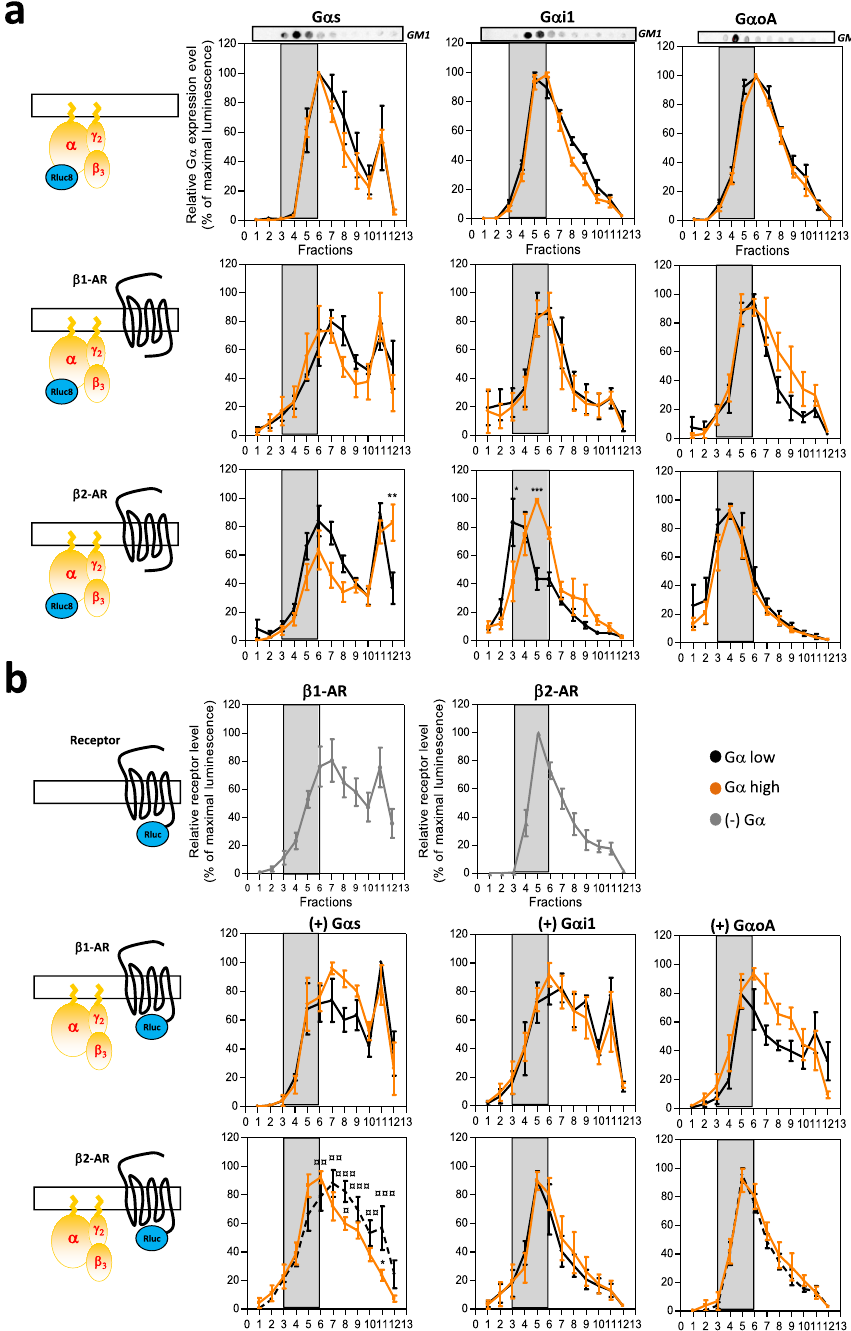
Figure 6. G α expression level influences G α subunit and β -AR receptor compartmentalization in cholesterol- enriched membranes. Detergent-resistant-membranes were purified using a triton X-100 lysis method followed by a separation on sucrose gradient from ( a ) HEK293T cells co-expressing high (orange) and low (black) expression levels of G α s-Rluc8 (left panel), G α i1-Rluc8 (middle panel) or G α oA-Rluc8 (right panel) along with G β 3 and G γ 2 subunits in the presence or not (upper panels) of untagged β -AR receptors, ( b ) HEK293T cells co-expressing β 1-AR-Rluc or β 2-AR-Rluc alone (upper panels) or in the presence of high (orange) or low (black) expression levels of untagged G α s (left panels), G α i1 (middle panels) or G α oA (right panels) and G β 3 and G γ 2 subunits. Relative receptor or G α subunit expression levels were quantified in each sucrose fractions by recording of the total luminescence. Results are expressed as the percentage of the maximal luminescence measured from all fractions in each experiment. Grey boxes highlight raft nano-domains enriched fractions, identified by detection of the GM1 protein (upper dot plot). Data represent the mean ± s.e.m. of at least three independent experiments. The statistical significance of the difference in membrane distribution in low versus high conditions ( * ) or versus receptor alone (¤) was assessed using two-way ANOVA followed by a Bonferroni posttest ( * P < 0.05, ** P < 0.01, *** P <